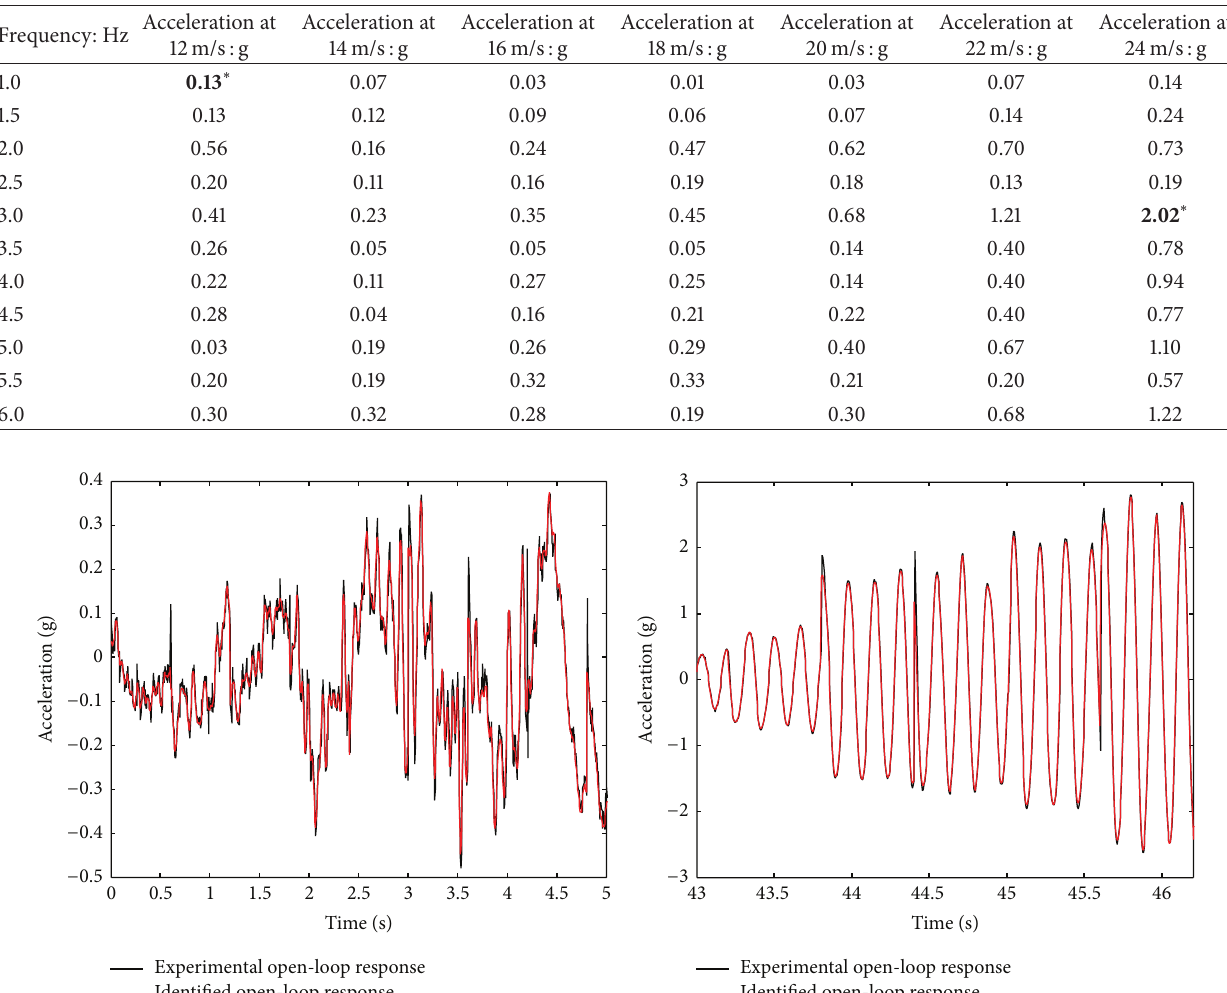
Table 5: Gust response alleviation result for fixed frequency and varying velocities.